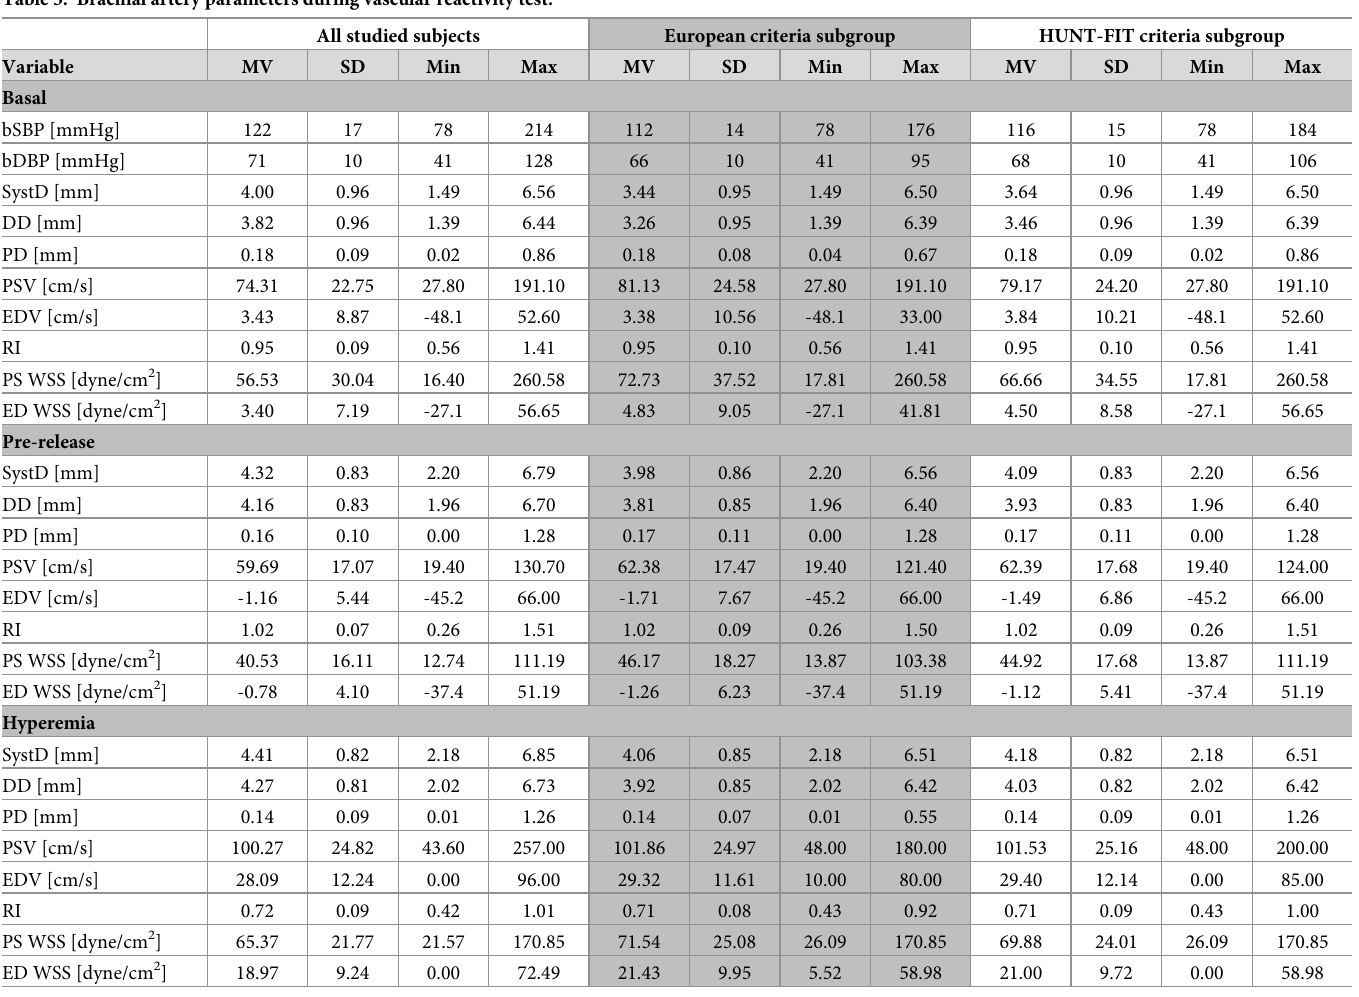
Table 3. Brachial artery parameters during vascular reactivity